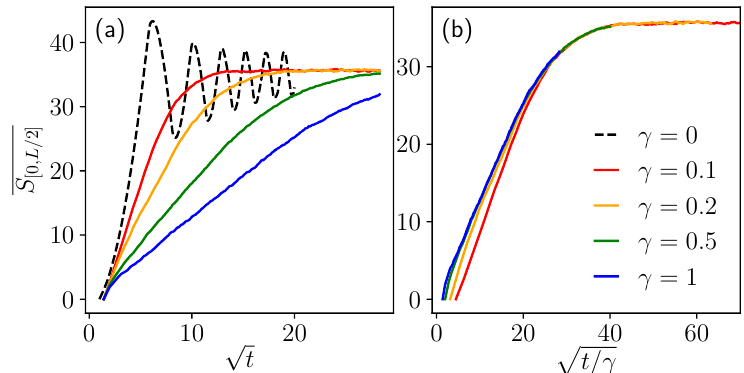
Figure 8: Averaged EE in the interval [ 0, L / 2 ] (in an periodic chain with L = 128) of quantum trajectories satisfying the stochastic Schrödinger equation (40) for various values of γ . The initial condition is the Néel state (10). About 20 QT’s are aver- aged over for each curve. The simulation is performed with a method similar to that described in Section 3. (a) The averaged EE grows as ∝ law value nearly identical to the free-fermion saturation EE ( γ = 0, dashed curve). (b) The same data is plotted against a re-scaled time